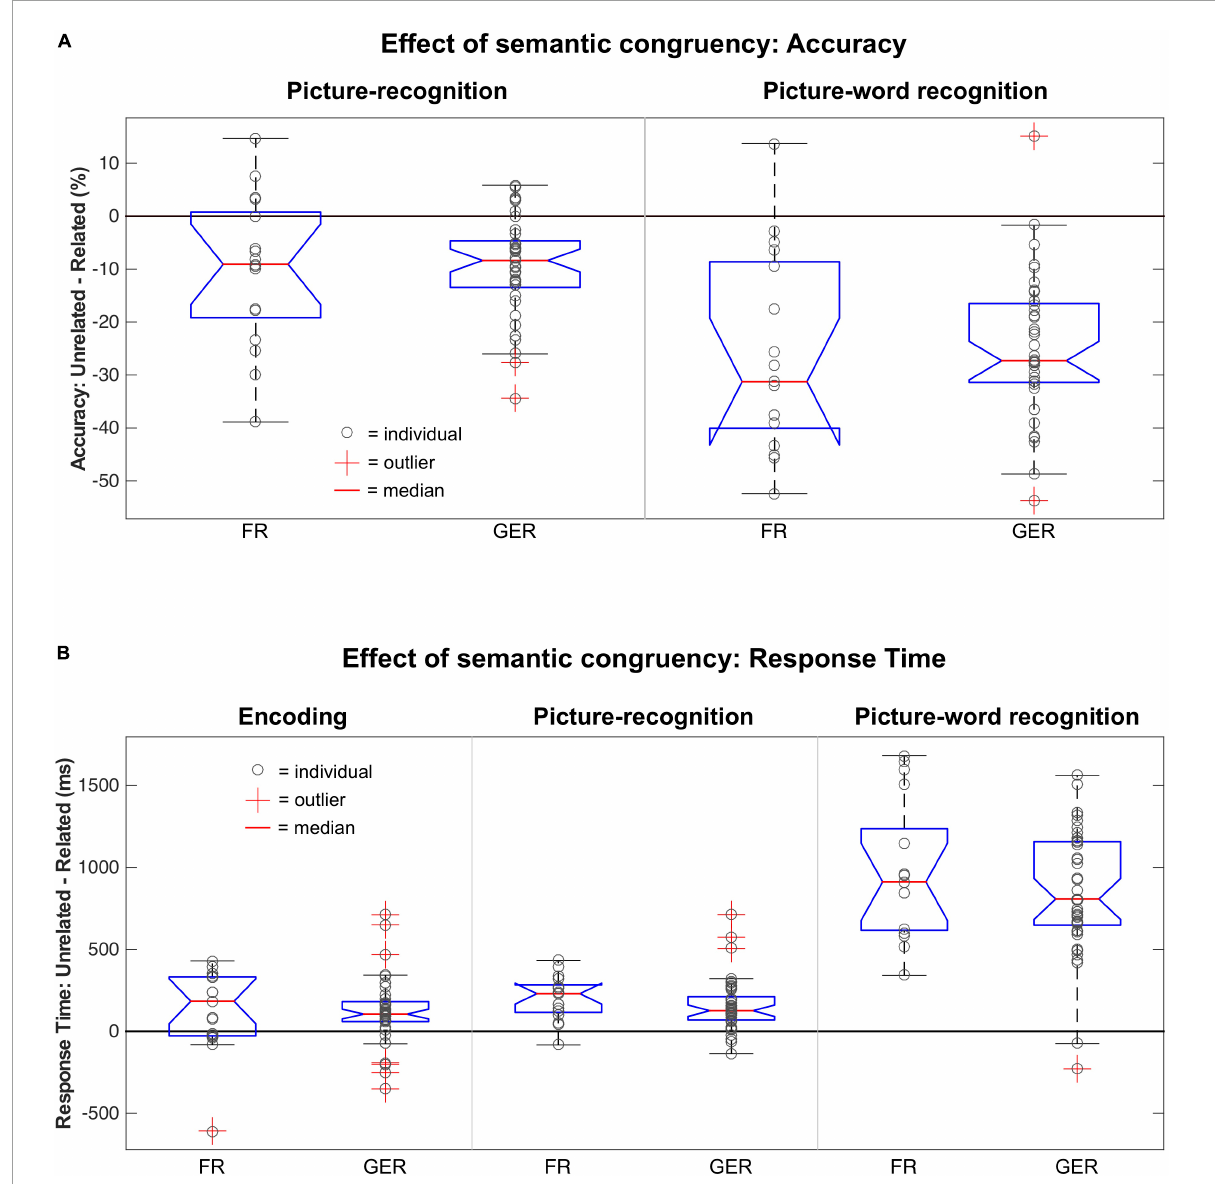
FIGURE8 Modulation of semantic congruency effects on behavior by language . (A) Boxplot of differences in recognition accuracy for Unrelated vs. Related stimuli based on the choice of language (FR, French; GER, German) during picture-recognition (left) and picture-word recognition (right). (B) Boxplot of differences in Response Times for Unrelated vs. Related stimuli based on the choice of language (FR, French; GER, German) during encoding (left) picture-recognition (middle) and picture-word recognition